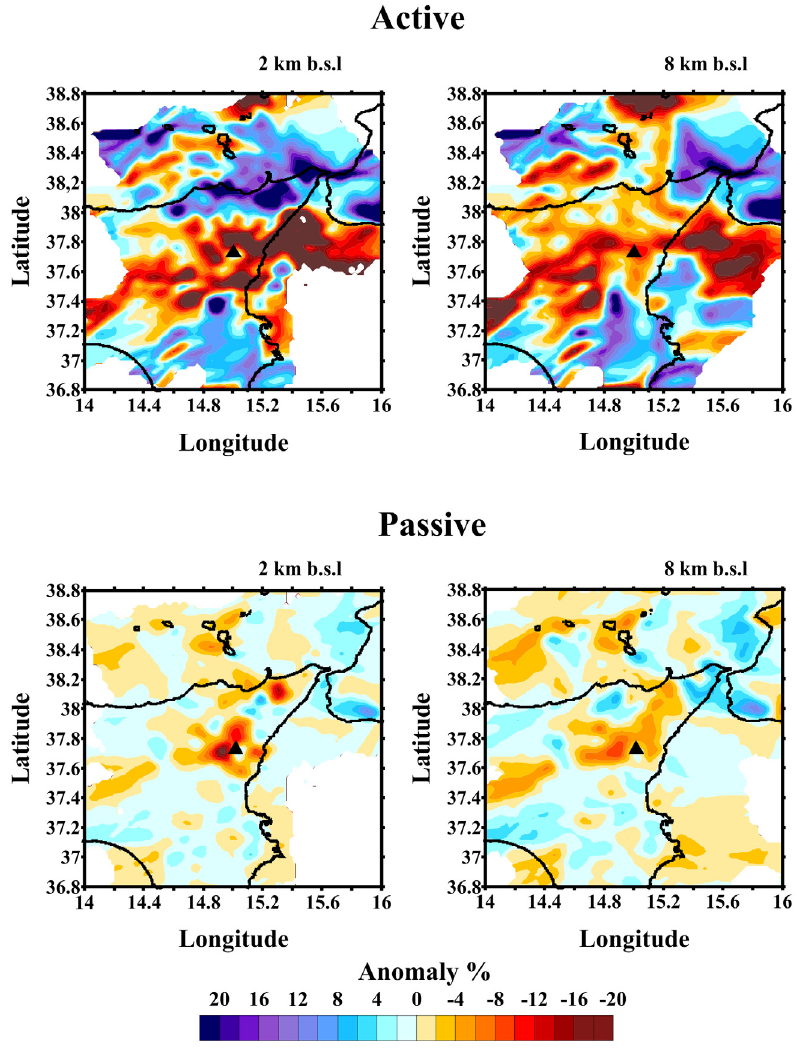
Figure 7. Horizontal layers (2 km b.s.l. in the left column and 8 km b.s.l. in the right column) of the real data inversion of the TOMO-ETNA